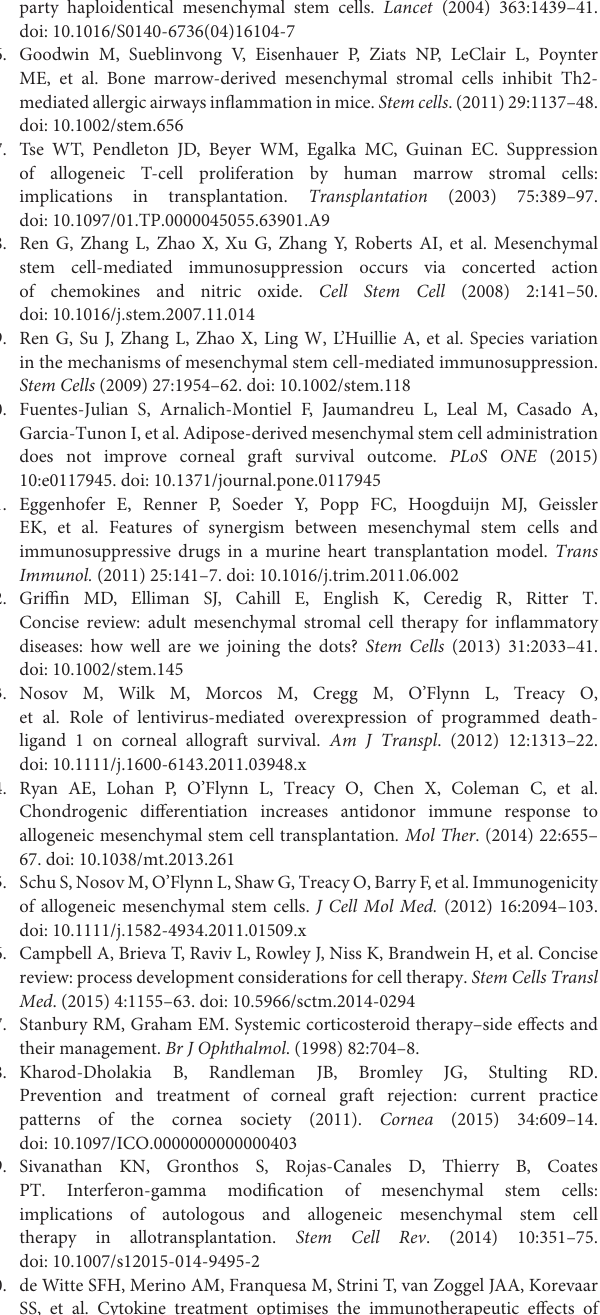
Supplementary Figure 1 | MSC were characterized by flow cytometry using standard markers (A) CD90, (B) CD73, (C) MHC-I, (D) MHC-II, (E) CD45, and (F)